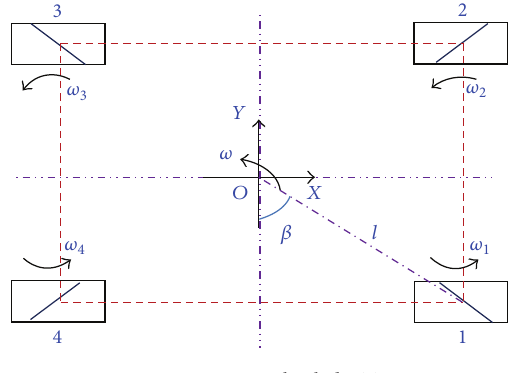
Figure 3: Four-wheeled